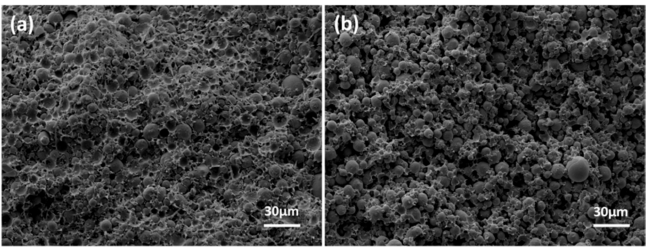
Figure 4. SEM micrographs of green parts C: ( a ) before and ( b ) after solvent debinding in xylene at 60 ◦ C for 23 h.